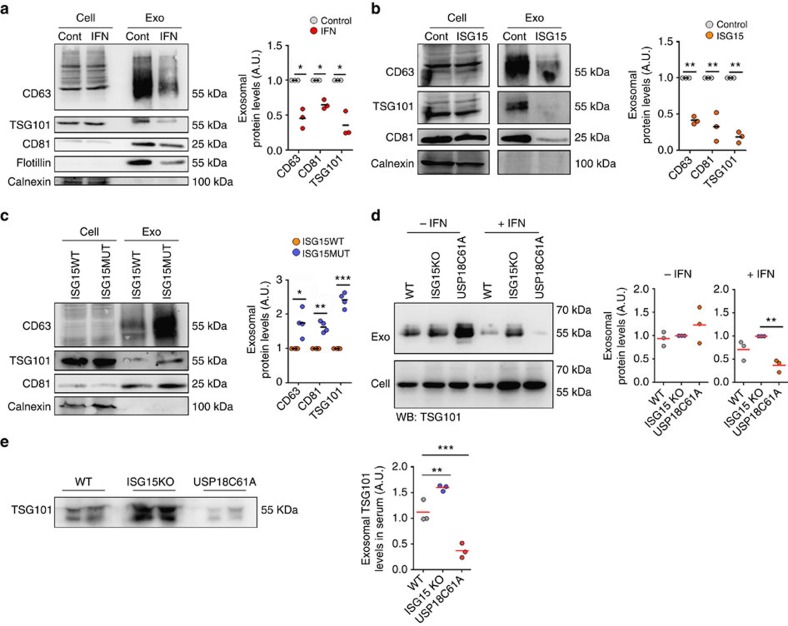
ISGylation inhibits exosome secretion.(a) Western blot analysis of EVs purified by serial ultracentrifugation from cell culture supernatants from equal numbers of Jurkat T cells untreated (Cont) or treated with 1,000 U ml−1 IFN-I for 16 h. Cells and EVs (Exo) were blotted for the exosomal markers CD63, TSG101, Flotillin and CD81, and for the endoplasmic reticulum marker Calnexin. Right graph: quantification of exosomal protein levels in the EVs obtained from IFN-I-treated and untreated cells in three independent experiments. (b) Western blot analysis of the EVs obtained from equal numbers of untransfected HEK293 cells (Cont) or co-transfected with ISG15 and the ISGylation machinery; E1, E2, E3 ligases (ISG15). Cells and EVs (Exo) were blotted for CD63, TSG101, CD81 and Calnexin. Right graph: quantification of exosomal protein levels in the EVs obtained from untransfected HEK293 cells or co-transfected with ISG15 and the ISGylation machinery in three independent experiments. (c) Western blot analysis of the EVs obtained from equal numbers of HEK293 cells co-transfected with plasmids encoding the ISGylation machinery and the functional (ISG15WT) or mutated ISG15 (ISG15MUT). Cells and EVs (Exo) were blotted for CD63, CD81 and Calnexin. Right graph: quantification of exosomal protein levels in four independent experiments. (d) Western blot analysis of the EVs obtained from equal numbers of WT, ISG15KO and USP18C61A BMDMs treated 16 h with IFN-I or left untreated. Cells and EVs were blotted for TSG101 and quantification of exosomal protein levels of IFN-I-treated and -untreated cells is shown for three independent experiments. (e) Western blot analysis of the EVs obtained in blood serum from poly(I:C)-injected WT, ISG15KO and USP18C61A mice. EVs were isolated from 250 μl of serum and blotted for TSG101. Right graphs: quantification of exosomal TSG101 protein levels of three mice per genotype; t-test *P-value<0.05, **P-value<0.001 and ***P-value<0.0001.